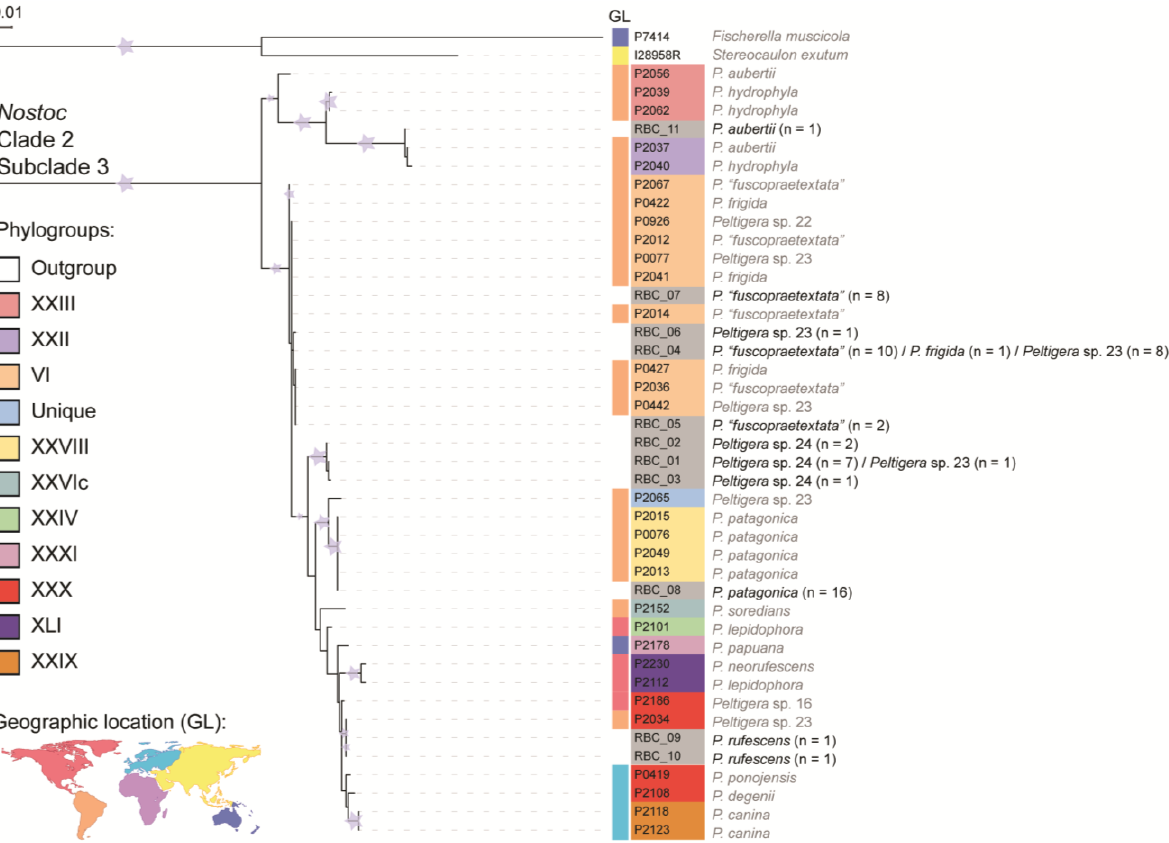
Figure 5. Phylogenetic analysis of Nostoc cyanobionts. The best ML tree resulting from a RaxML analysis of the rbcLX locus from 31 reference sequences, 11 sample sequences and 2 outgroup sequences from Fischerella muscicola and Nostoc from Stereocaulon exutum is shown (Table S1, Table S3). Each sample is colored according to the phylogroups I–VI delimited by O’Brien et al. [27] and phylogroups VII–XLVIII delimited by Magain et al. [13]. The Peltigera mycobiont of each Nostoc representative is next to the tree nodes. Color boxes represent the geographical localization (GL) from where the sample was collected. Branches with stars received bootstrap support ≥ 75%. The rbcLX haplotypes generated in this study are indicated in grey.